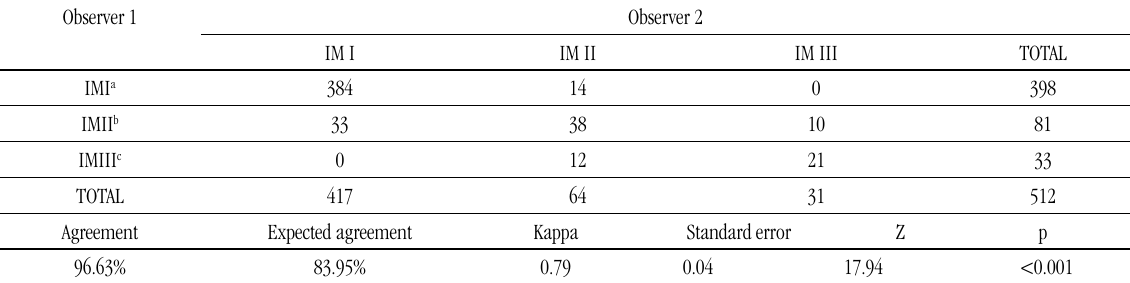
TAbLE 1 – Contingency table and concordance of the results generated by the two experts. Observer